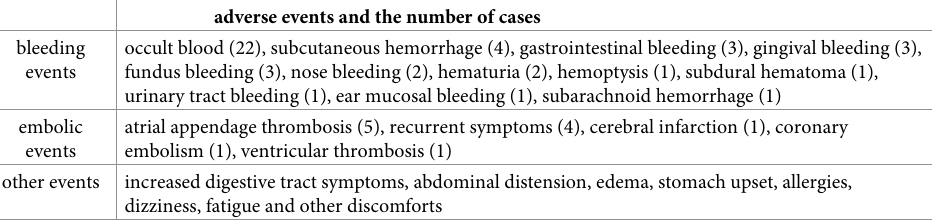
Table 7. Adverse events. adverse events and the number of